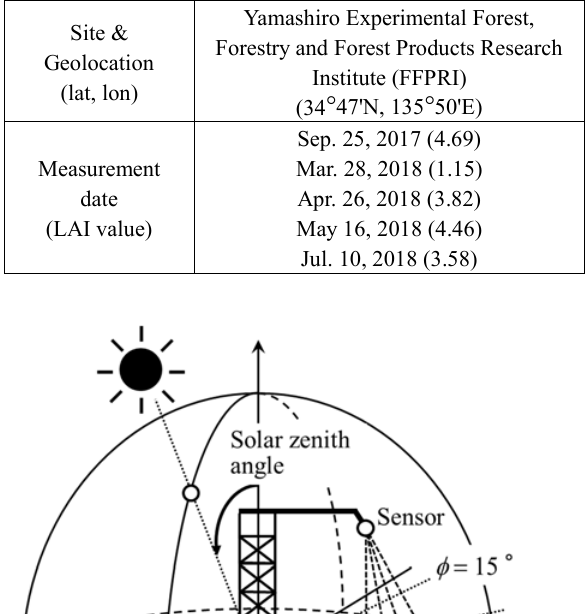
Table 2. Measurements in the study area